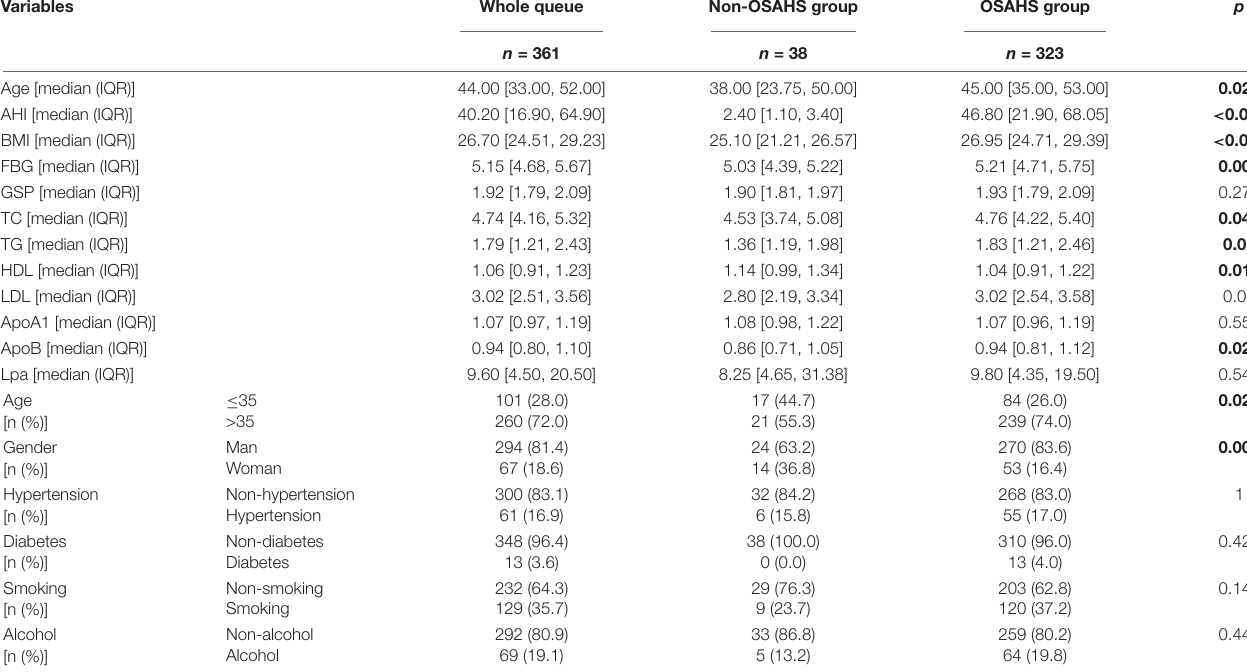
TABLE 1 | Comparison of baseline characteristics, AHI and blood indexes between the non-OSAHS and OSAHS groups. Variables Whole queue Non-OSAHS